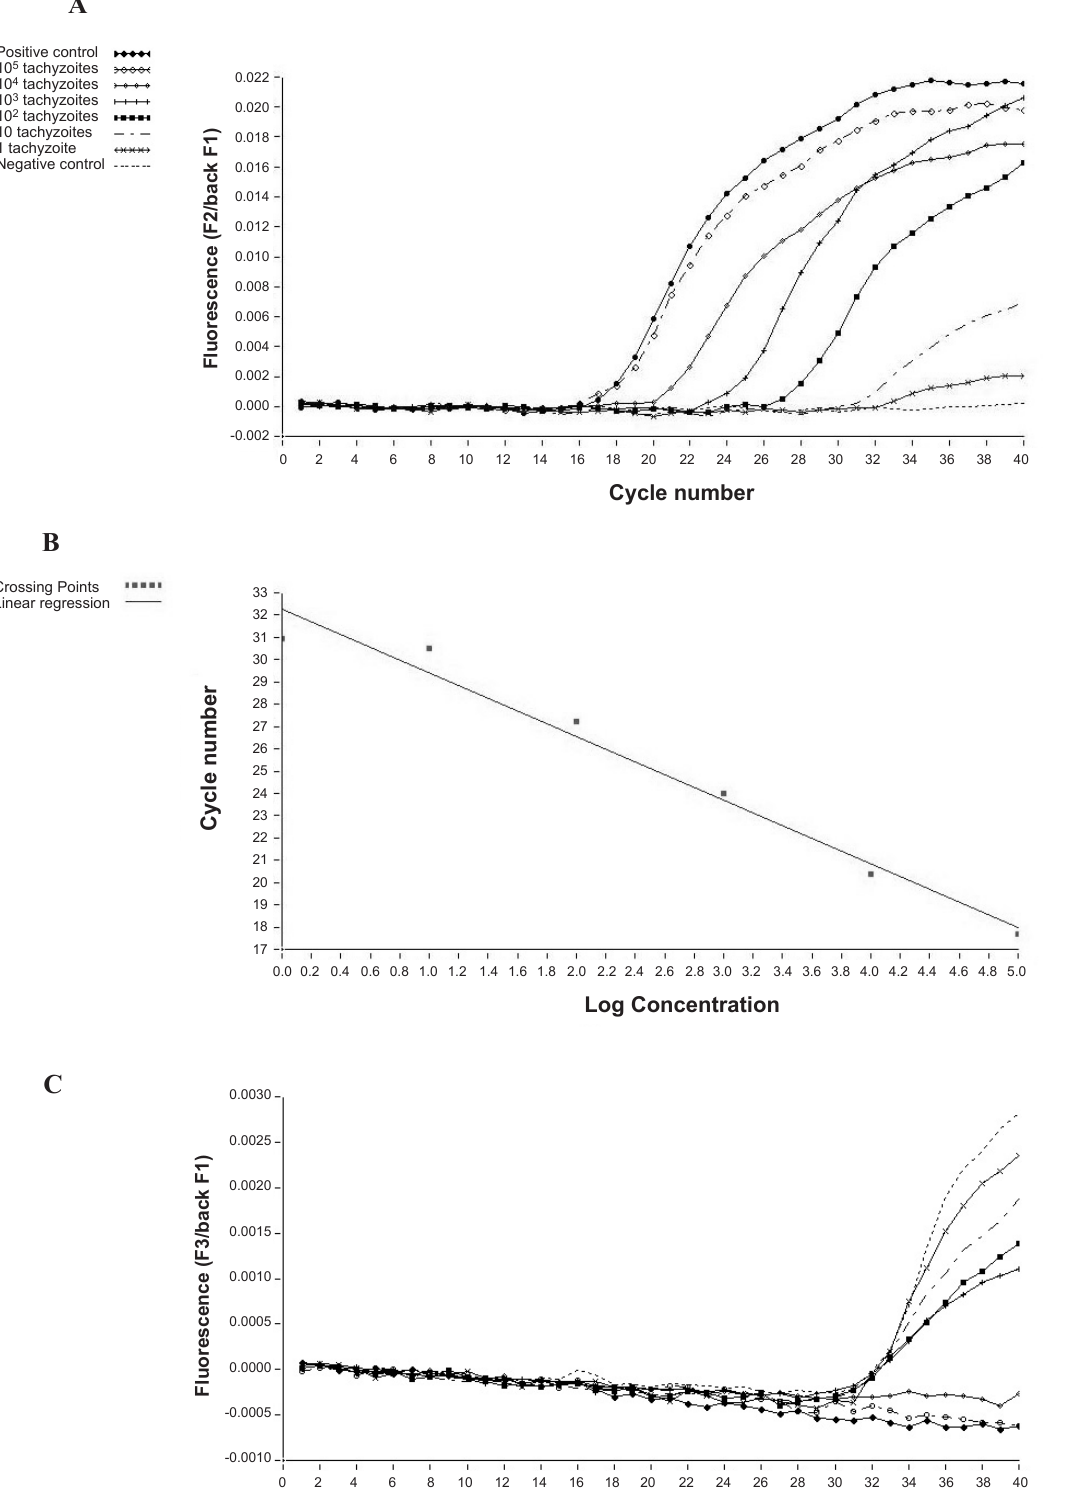
Fig. 1. – Establishment of the standard curve for quantification of T. gondii and co-amplification of Internal Amplification Control. Amplification plot obtained from serial dilutions of T. gondii (A) in order to construct a standard curve (B) Amplification plot of cIAC in the same run (C). Serial dilutions of T. gondii ranging from 40 to 4.10 6 in one ml of AF were independently extracted and 5 µl of each were amplified cor- responding to 1 to 10 5 tachyzoites. cIAC was added at a concentration of 10 3 copies/reaction and was detected from 1 to 10 3 tachyzoites. A positive control corresponding to T. gondii DNA was performed in each